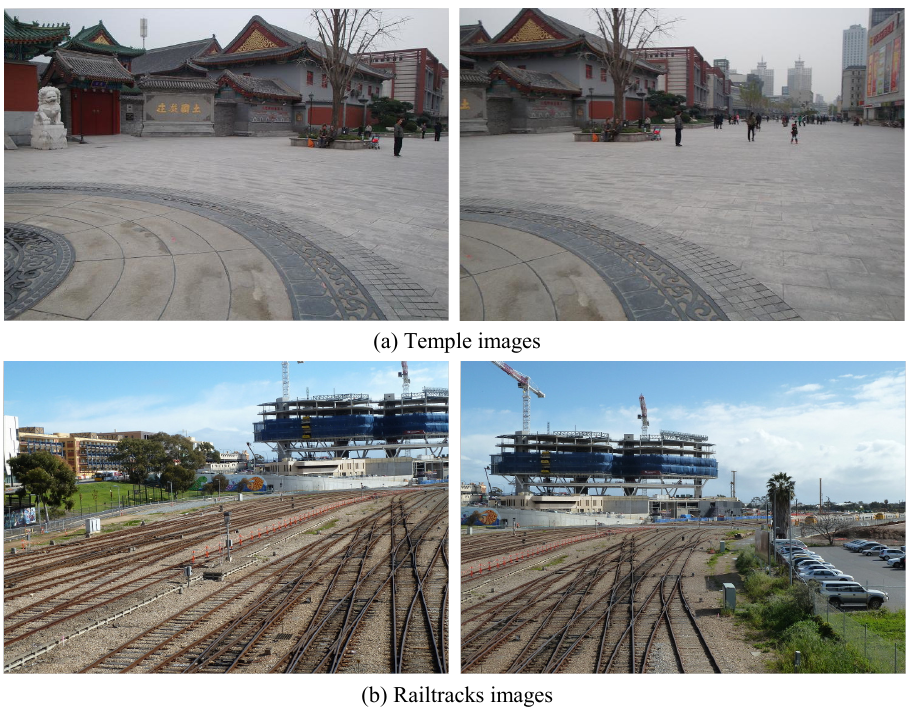
Figure 3. Original images for